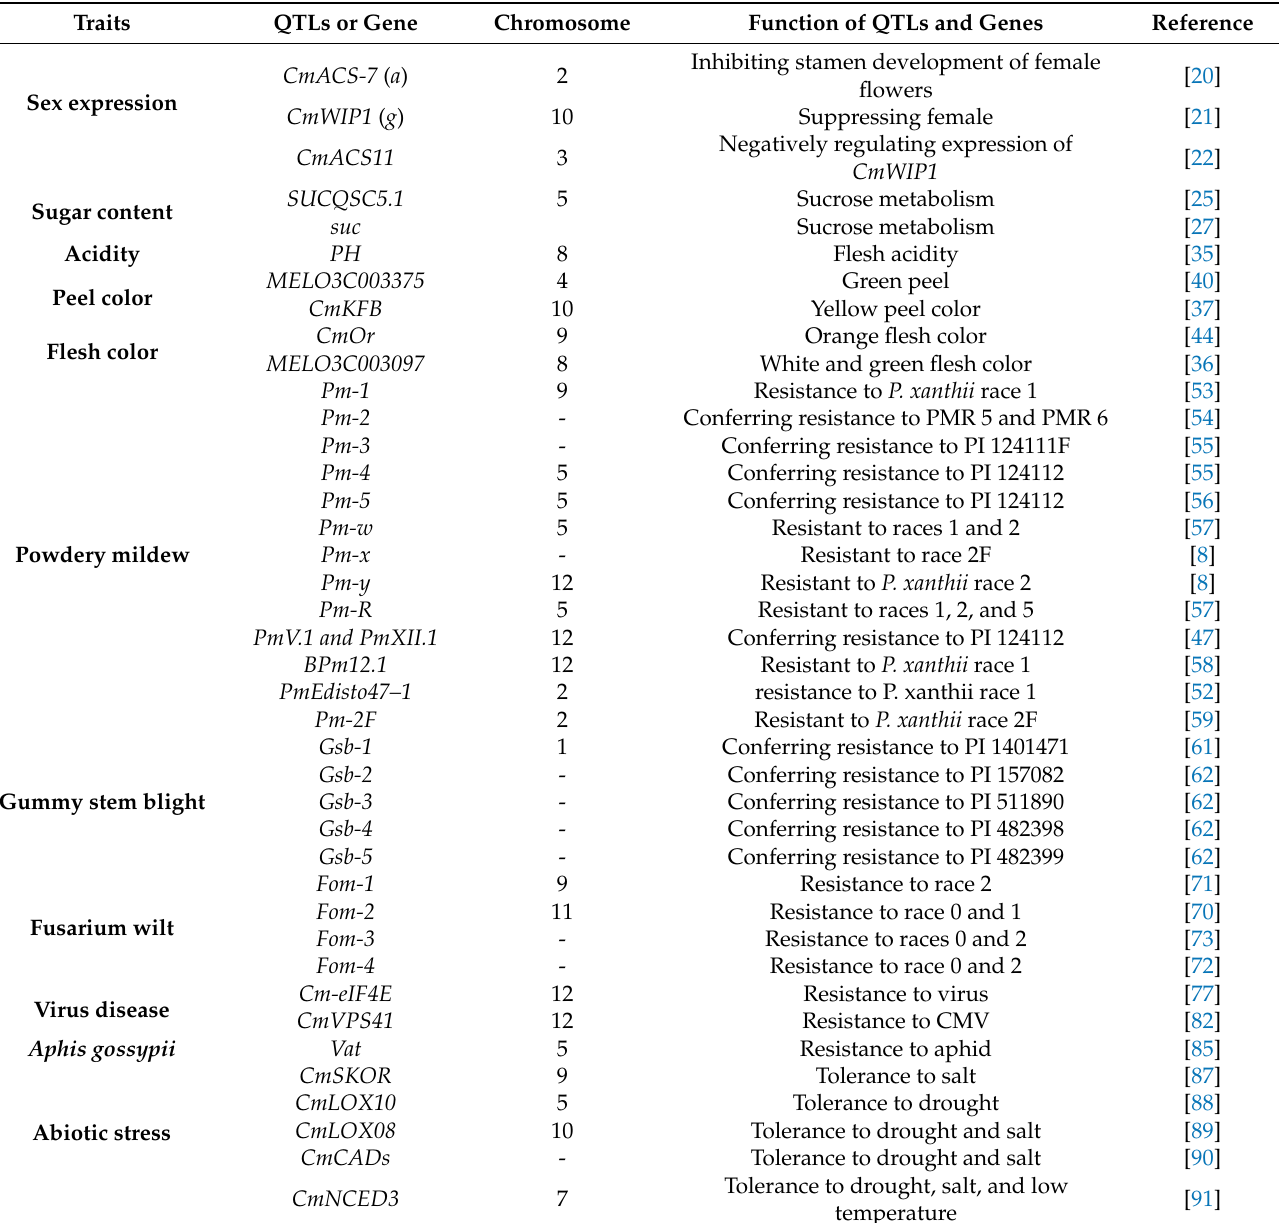
Table 1. The main QTLs and genes for melon were reported in previous